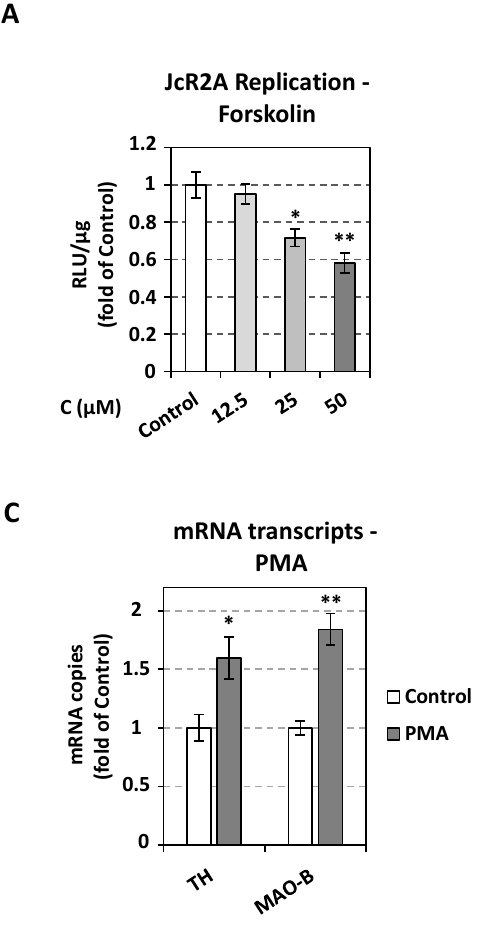
Figure 6. Effect of PKA and PKC activation on HCV replication. ( A , B ) Huh7.5 cells were inoculated with JcR2A (MOI = 0.5) for 4 h and then treated for 72 h with the indicated concentrations of Forskolin ( A ), PMA ( B ), or mock-treated (Control). Virus replication-derived R-Luc activity was determined and expressed as RLU/ µ g of total protein amount. ( C ) Effect of PMA treatment on TH and MAO-B transcription. Huh7.5 cells were treated with 2.4 µ M PMA or mock-treated (Control). TH and MAO-B mRNA levels were quantified by RT-qPCR and normalized to the mRNA levels of the housekeeping gene YWHAZ. In all panels, values from infected non-treated cells were set to one. Bars represent mean values from three independent experiments in triplicate. Error bars indicate standard deviations. * p < 0.01, ** p < 0.001 vs. Control.